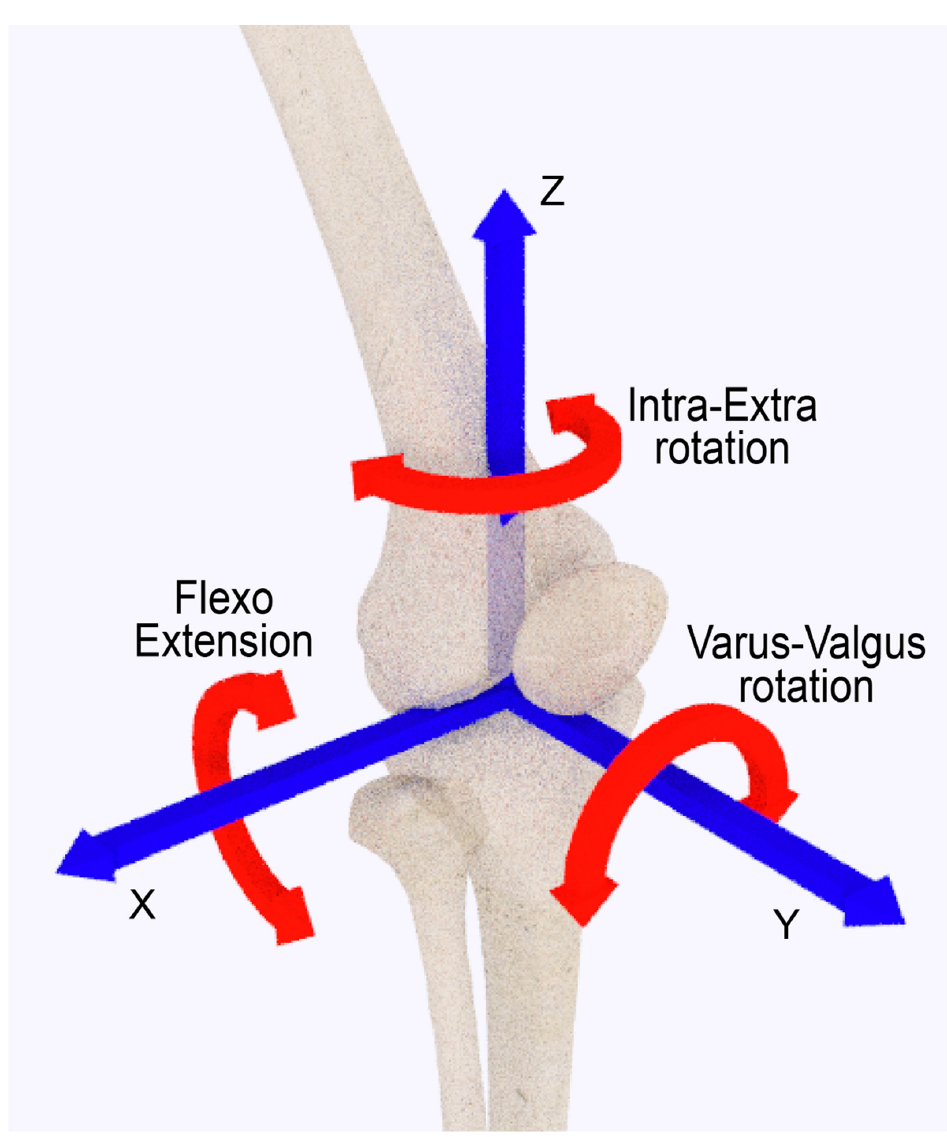
Figure 5. Tibial based TKR reference